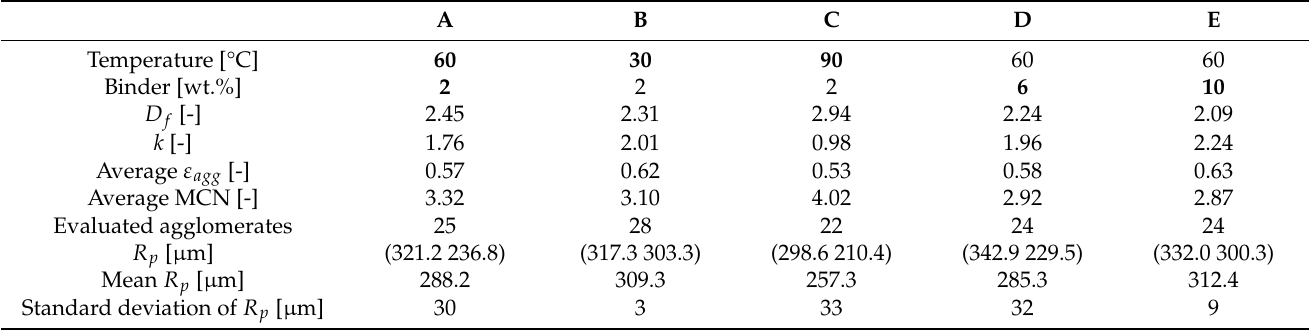
Table A1. Experimental findings for each